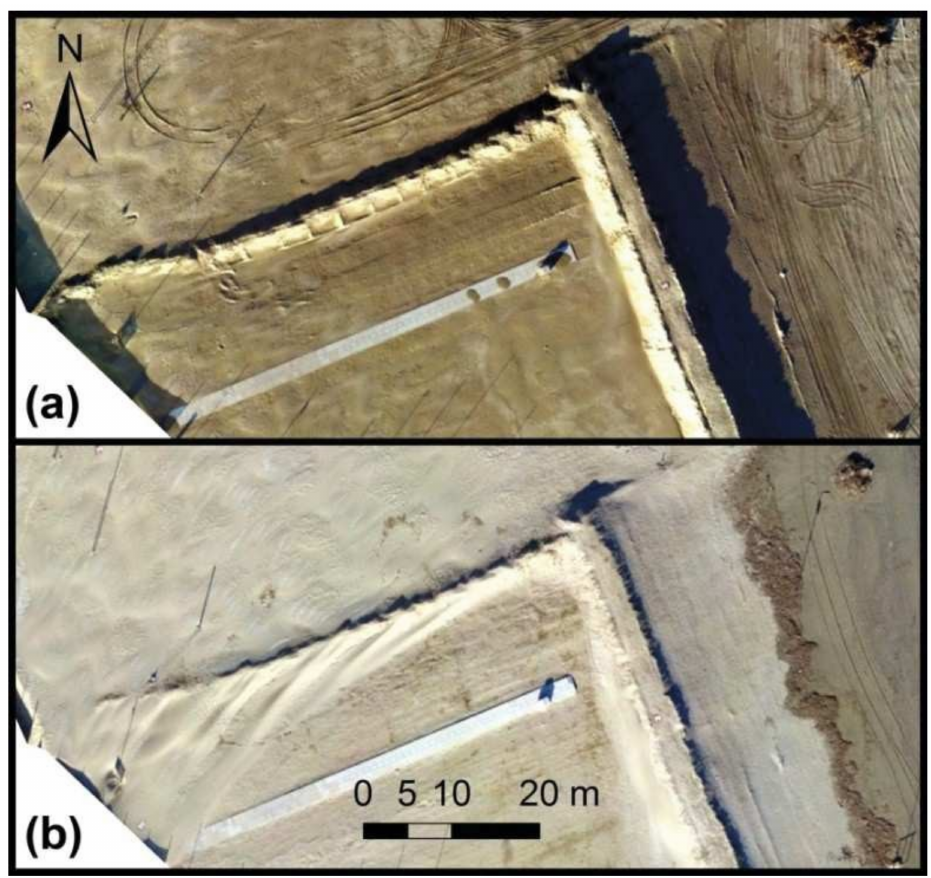
Figure 12. Aeolian morphological features: orthophotos from ( a ) 21 December 2016 and ( b ) 20 January 2017. The tracks left by the bulldozers during the building activity are still visible in ( a ). Aeolian features visible in ( b ) at the protection